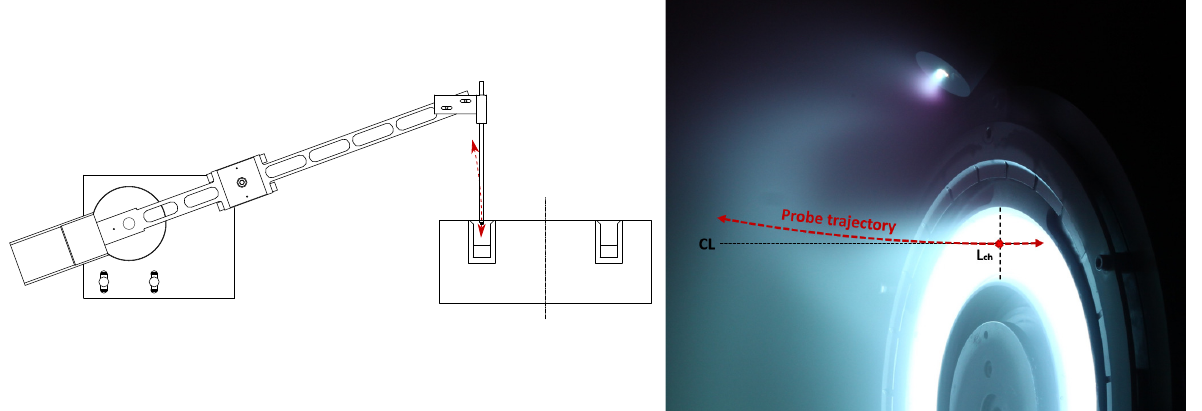
Figure 2. Scheme of the robotic arm for fast probe insertion ( left ); HT5k DM2 thruster firing in the M1 configuration ( right ). The red dashed line shows the probe trajectory, the black dotted line represents the channel centerline and the vertical dashed line highlights the channel exit coordinate ( z = L ch